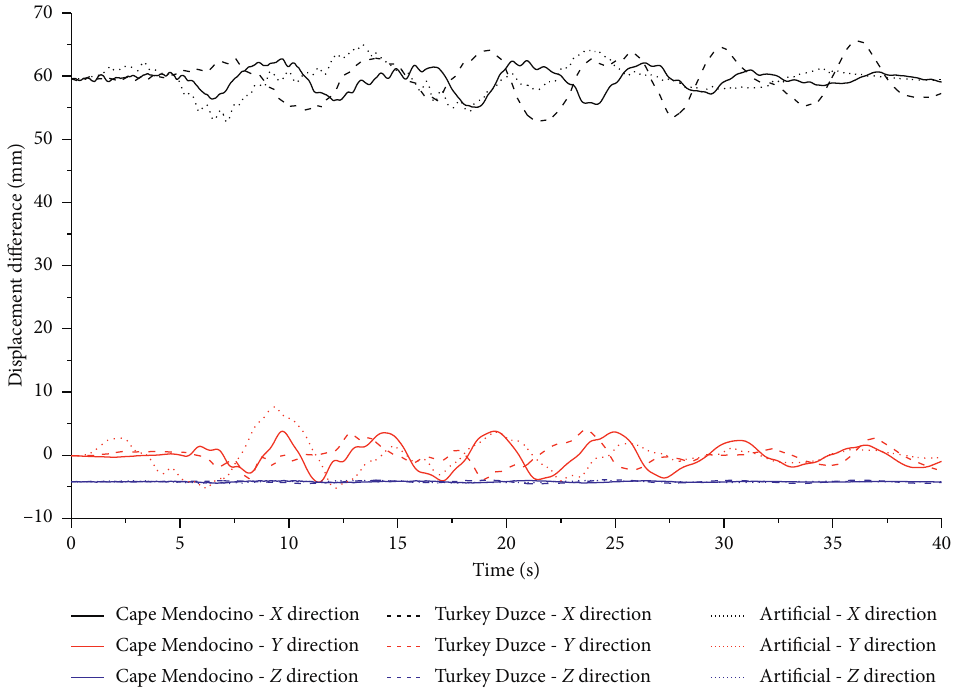
Figure 16: Displacement difference–time curves of climbing formwork and core tube under the climbing